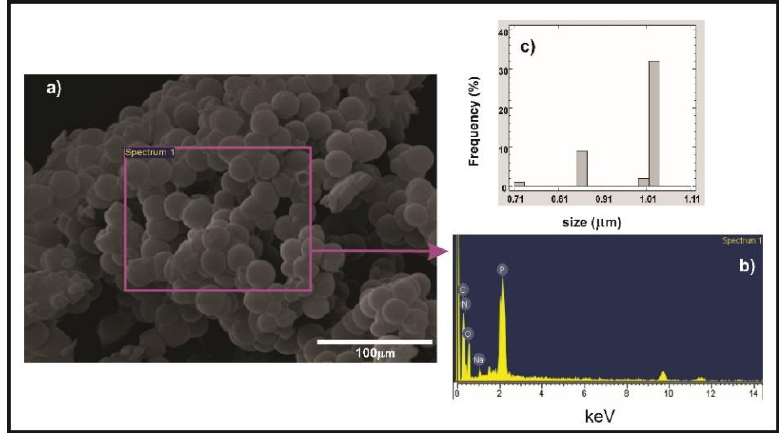
Figure 2. ( a ) Scanning electron microscopy (SEM) micrographs of the McMAPs and ( b ) size distribution histogram for the microcapsules. ( c ) Energy-dispersive X-ray spectrometry (EDS) analysis.